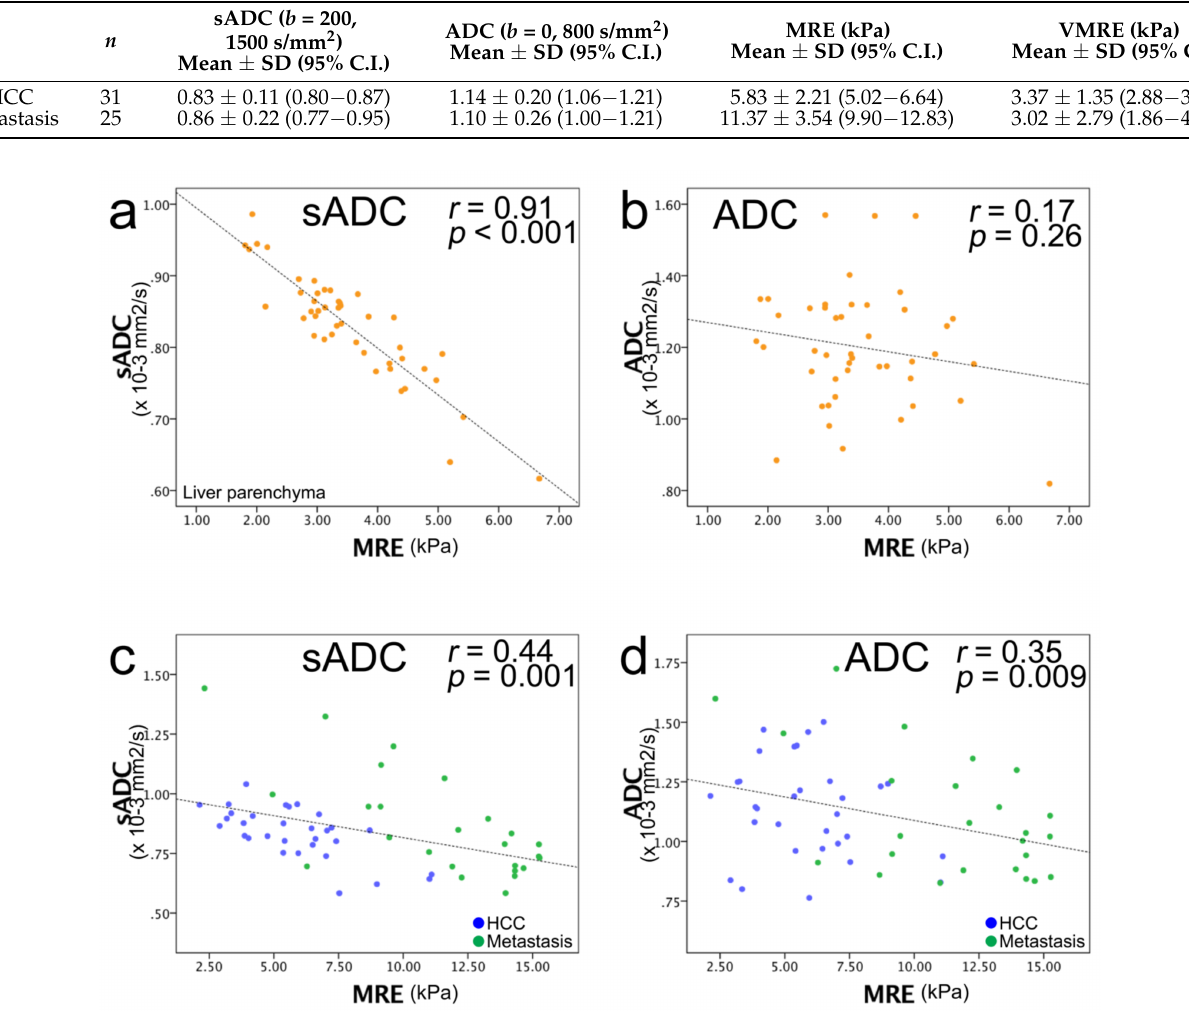
Figure 3. Box plots of ADC values of HCC versus metastasis for ( a ) sADCs and ( b ) ADCs. Mean sADC and ADC values were not significantly different between the HCCs and metastasis. Box plots of the stiffness of the HCCs versus metastasis for ( c ) MRE shear modulus ( µ MRE ) and ( d ) VMRE shear modulus ( µ diff ). The mean metastatic µ MRE value was significantly higher than that of HCCs. The mean µ diff was not significantly different between the HCCs and metastasis. Table 3. Mean apparent diffusion coefficient (ADC) and stiffness (kPa) values of liver tumors.